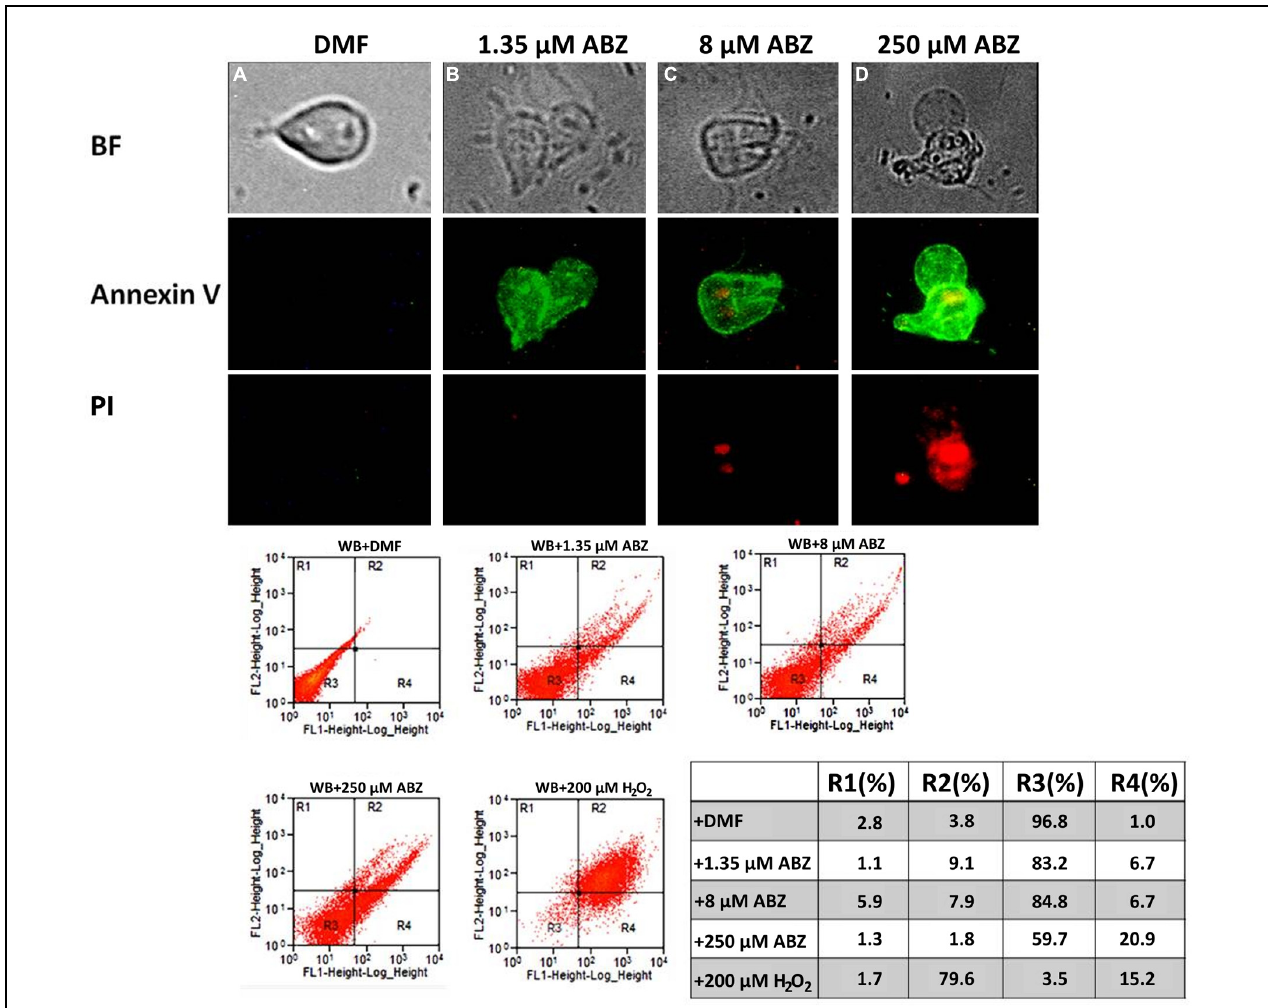
FIGURE 7 | Albendazole induces apoptosis-like death in Giardia . Annexin V binding in the parasite’s cell surface (as indicator of early apoptosis) was detected as a consequence of translocation of phosphatidylserine to the plasmatic membrane (middle panel). The parasites were exposed to DMF (A) , 1.35 μ M (B) , 8 μ M (C) , 250 μ M (D) of ABZ for 16 h at 37 ◦ C. Then annexin V-FITC and PI (indicator of late apoptosis and necrosis) were added to the medium. Trophozoites´ micrographs are as follows: top panel: in BF; bottom panel: trophozoites stained with annexin V-FITC and PI. The FITC and PI